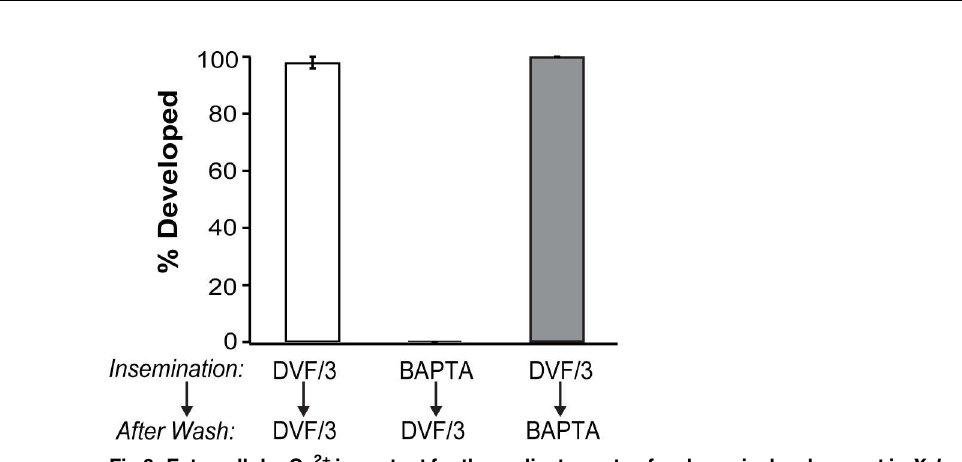
Fig 3. Extracellular Ca 2+ important for the earliest events of embryonic development in X . laevis . Incidenceof cleavagefurrow development from eggs inseminated in DVF/3 either with 0 or 3 mM BAPTA. After 30 minutes, inseminated eggs were washedtwice and moved to a new solution of DVF/3 with 0 or 3 mM BAPTA, as indicated.Embryos were assessed for the appearanceof cleavagefurrows 60–90 minutes after transfer (90–120minutes after sperm addition)(N = 75–85 eggs in 4 experimental